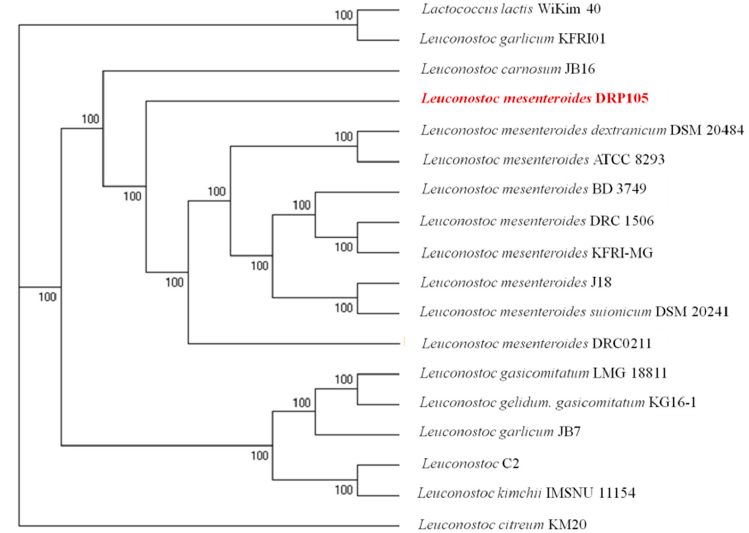
Figure 3. Gene Ontology (GO) annotation classification statistics of the Leu. mesenteroides DRP105 genome.